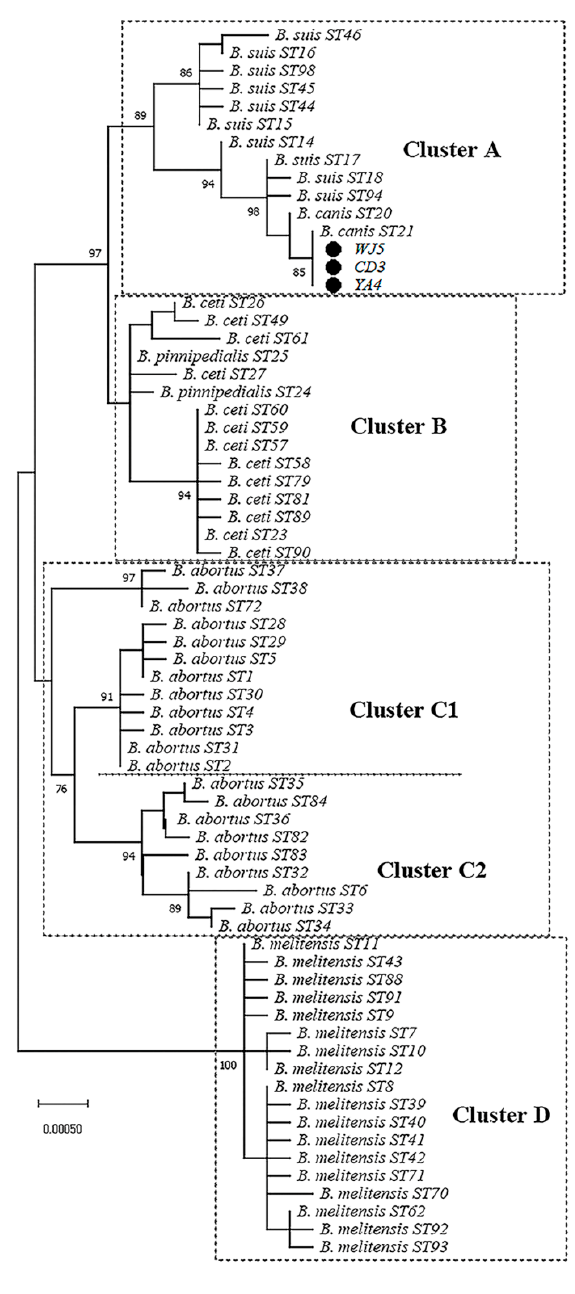
Figure 3. Dendrogram based on the MLST genotyping assay showing relationship of 3 B. canis iso- lates and 66 Brucella isolates in MLST database. ● The B. canis strains from pet dogs in Sichuan, China.